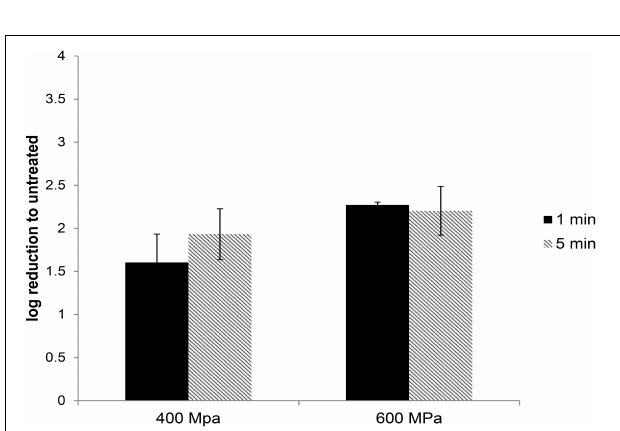
FIGURE 2 | The effect of HPP treatment on HEV-3c strain 47832c in cell culture media. The samples containing 2 × 10 6 RNA copies were treated at 400 and 600 MPa for 1 and 5 min at ambient temperature in triplicates and were inoculated onto A549/D3 cells. The HEV genome copy numbers in the supernatant were quantified at 14 d.p.i. using ddRT-PCR. The effect is shown in comparison to the untreated viral stock. The standard deviation (error bars) of three replicates is